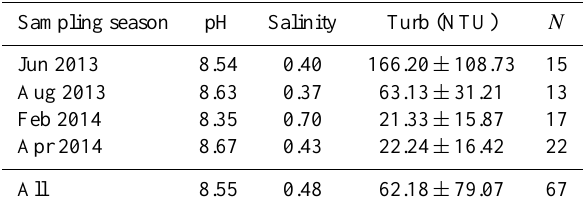
Table 1. Mean value of water quality parameters from June 2013 to April 2014. Turb denotes water turbidity; N denotes sampling numbers.